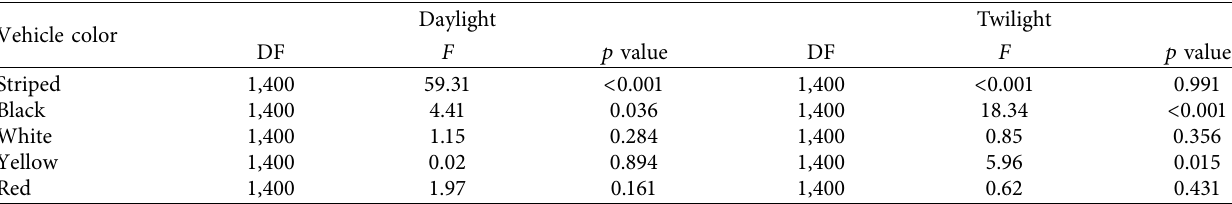
Table 4: Effects of vehicle size under the front identification